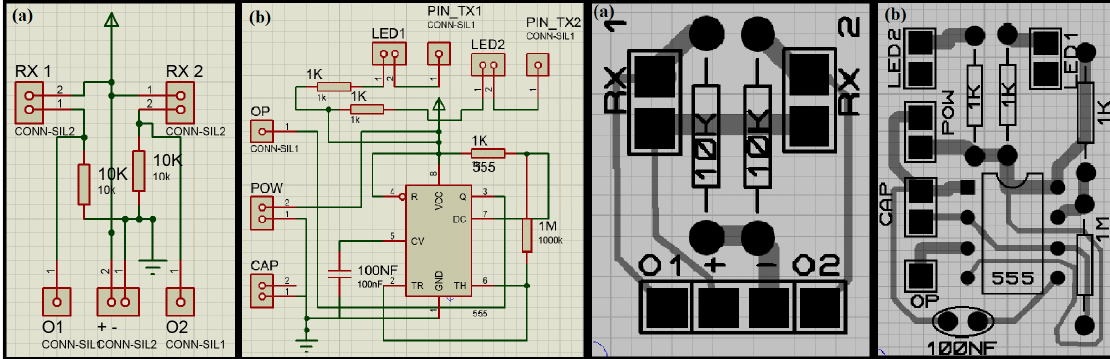
Figure 1. Schematic and layout of ( a ) Infrared (IR); ( b ) 555 PCBs.